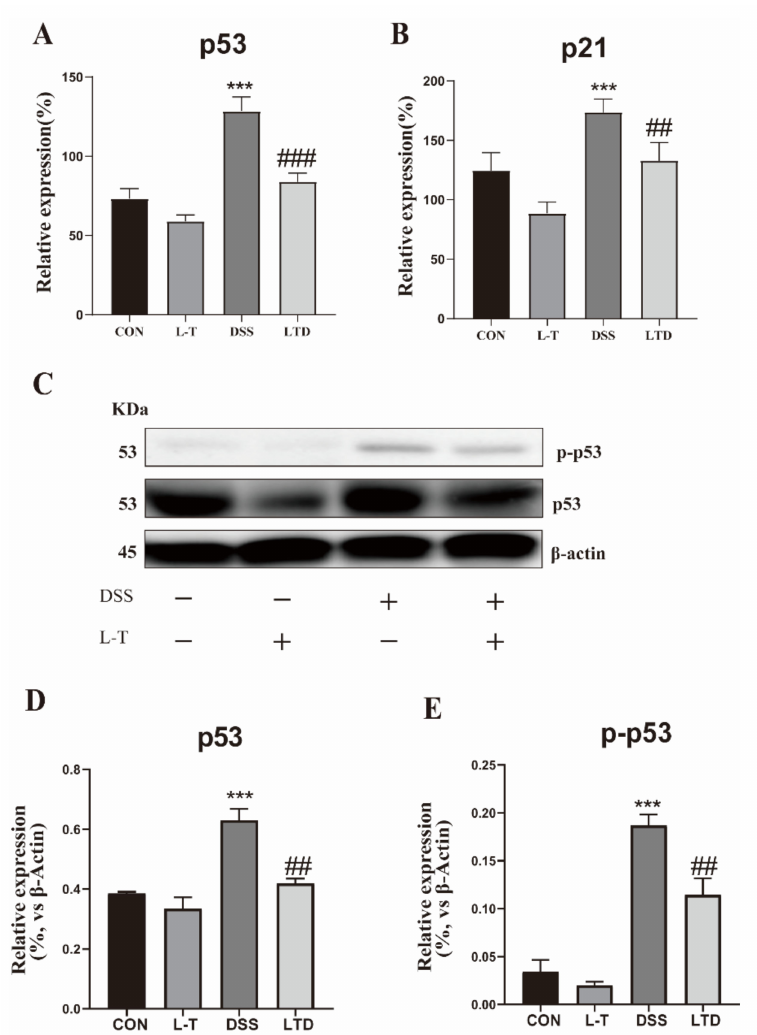
Figure 6. Effect of L-theanine on p53 signaling pathway of IPEC-J2 cells induced by DSS. ( A , B ) The mRNA relative expression of p53 and p21 genes were detected using RT-PCR assay ( n = 6). ( C – E ) The protein relative expression of p53 and p-p53 were detected using Western blotting assay ( n = 3). P < 0.01 and *** P < 0.001, compared with the CON group. ## P < 0.01 and ### P < 0.001 versus DSS